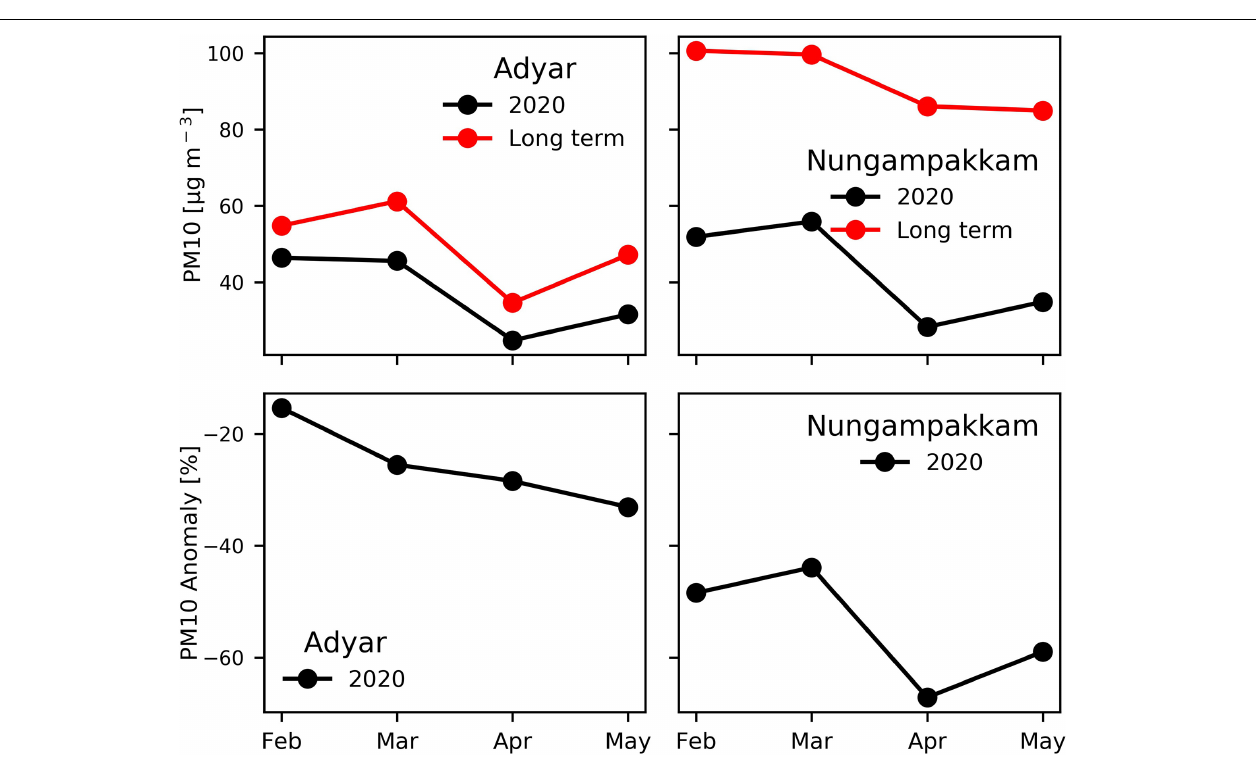
Frontiers in Marine Science |